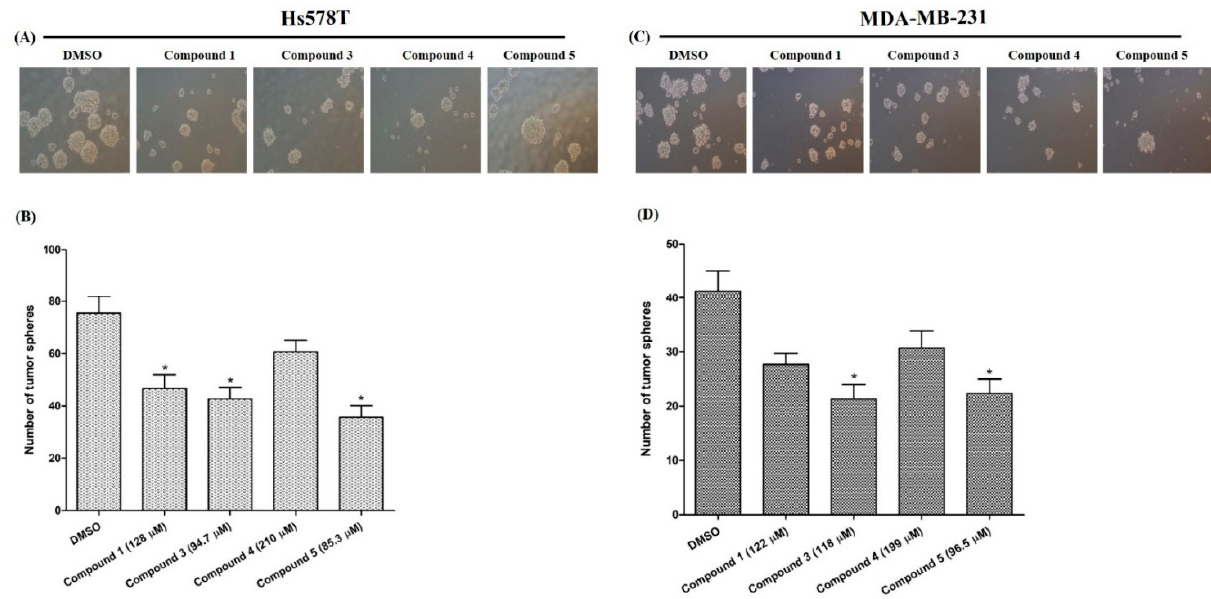
Figure 5. Reduction of the formation of the tumor-sphere. ( A ) and ( C ): the captured tumor-spheres after five days of treatment with tested compounds. ( B ) and ( D ): the number of tumor-spheres. Data are presented as the mean ± SD of three independent experiments. The bars with asterisks indicate significant differences from the control at p ≤ 0.05 (*).